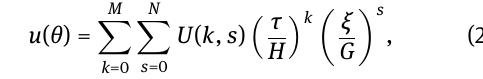
tion u (Eq. (15)) at different times for the heating case shown in Fig. 6. The solid curves indicate the profiles calculated from the following expression, which uses the transformed function U given by Eq. (18):